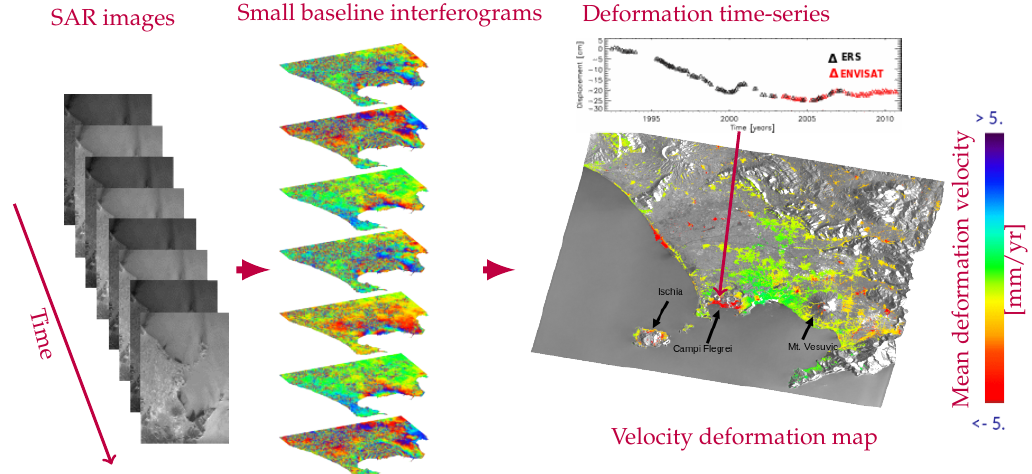
Figure 2. The SBAS-DInSAR algorithm processing flow: from left to right, large number of SAR data are processed to generate a stack of interferograms with small temporal and spatial baselines, from which velocity deformation maps and deformation time-series are